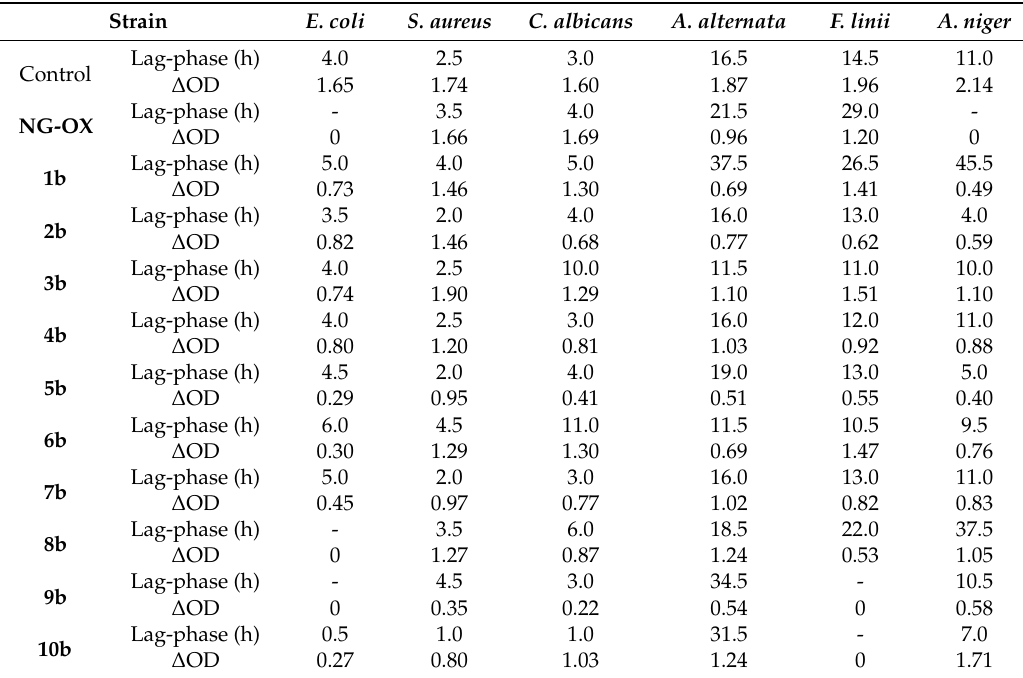
Table 2. Antimicrobial activity of oximes 1b – 10b